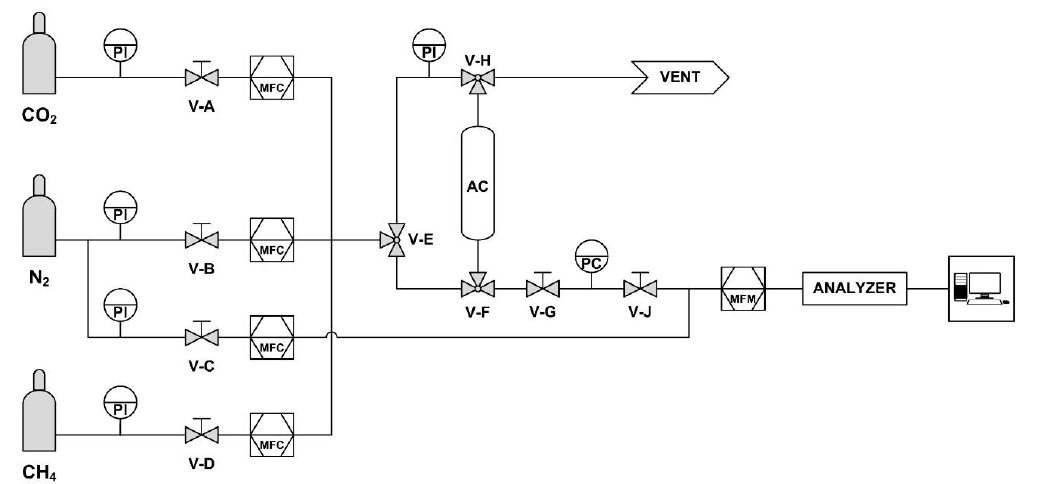
Figure 1. Flowsheet of the experimental apparatus: PI—pressure indicator; V-i—valves; MFC—mass flow controller; MFM—mass flow meter; PC—pressure controller; AC—adsorption column; analyzer—URAS ABB.